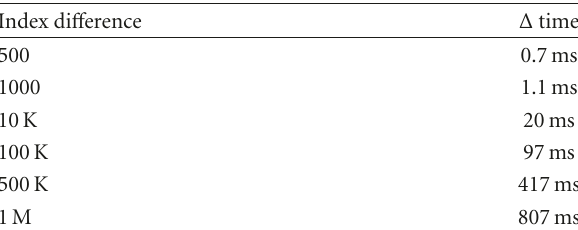
Table 3: Timing attack on Duc et al.’s protocol